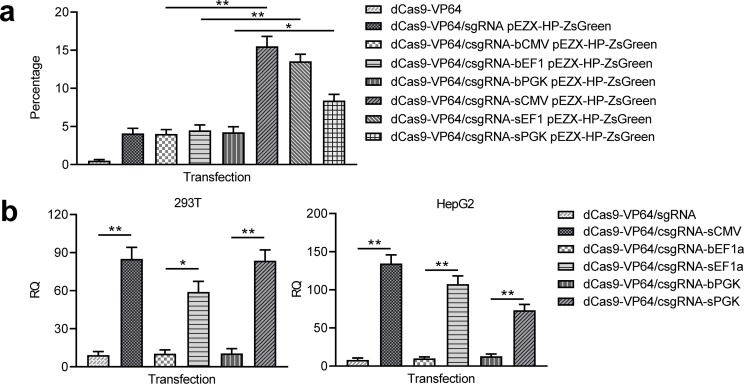
Activation of exogenous and endogenous genes with other trans enhancers.(a) Activation of exogenous reporter gene ZsGreen. The fluorescence intensity of cells was analyzed with flow cytometry. (b) Activation of endogenous HNF4α gene in 293T and HepG2 cells with two new trans enhancers, sEF1a and sPGK. The sCMV was used as a positive control for comparison. The blunt-end trans enhancers (bEF1a and bPGK) were also used as controls. Data are shown as mean ± SD, n = 3. The statistical difference was analyzed using Student’s t test. *, p<0.05; **, p<0.01.